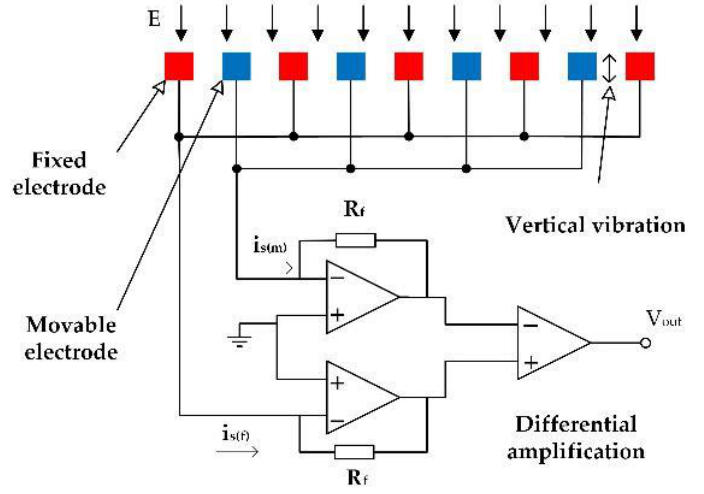
Figure 2. Working principle of the EFM.